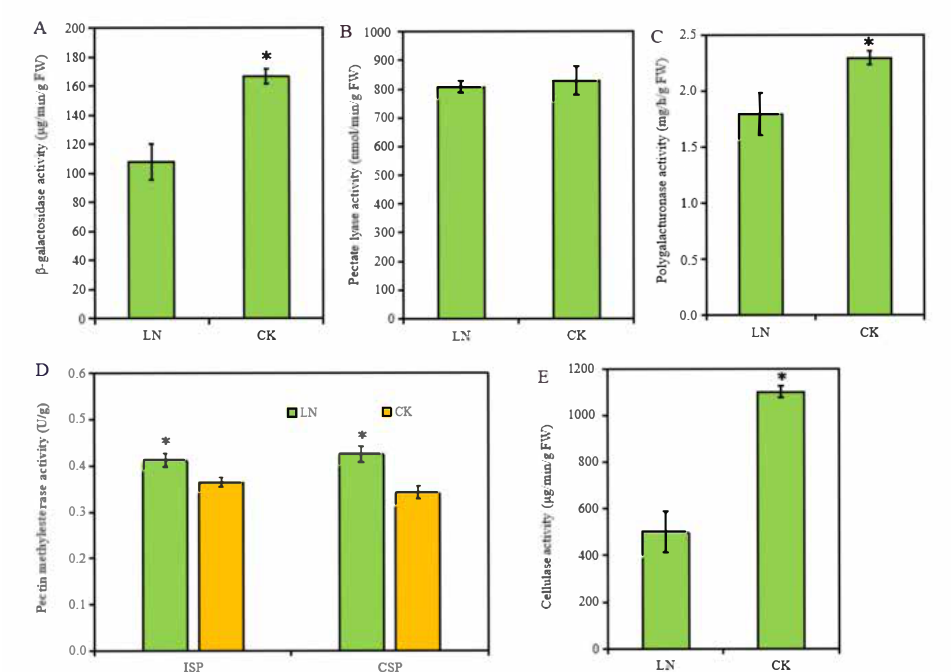
Figure 4. The enzyme activity related to pectin and cellulose in rapeseed roots under different N treat- ment. ( A – E ) Activities of β -galactosidase, pectate lyase, polygalacturonase, pectin methylesterase, and cellulase in rapeseed roots. The * represents the statistical significance at the levels of p < 0.05.